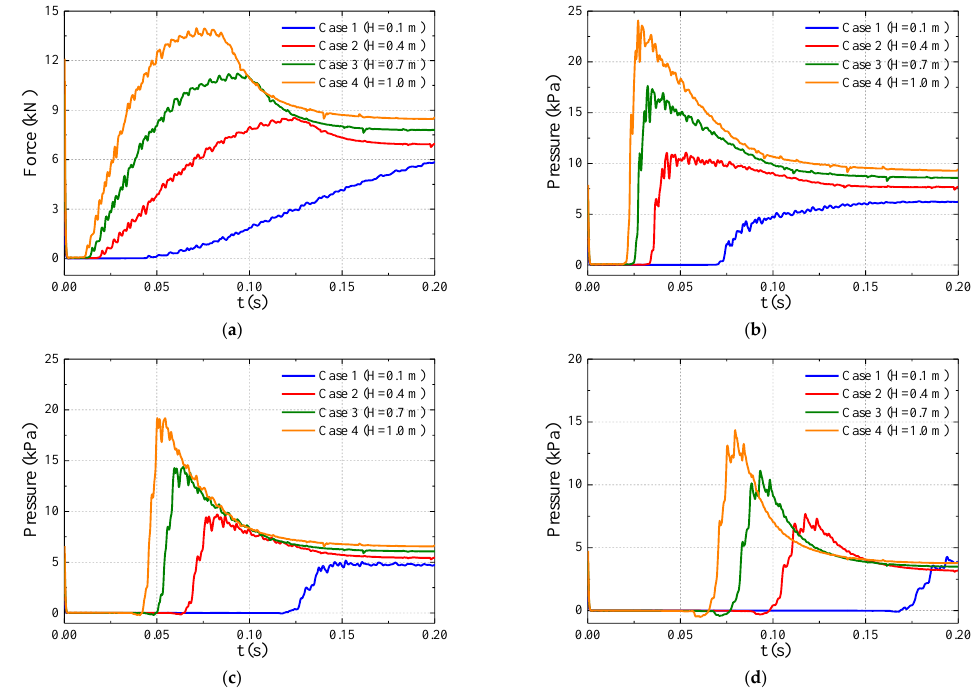
Figure 26. Impact force and pressure at different free falling heights: ( a ) vertical total force; ( b ) impact pressure at P1; ( c ) impact pressure at P3; ( d ) impact pressure at P5.